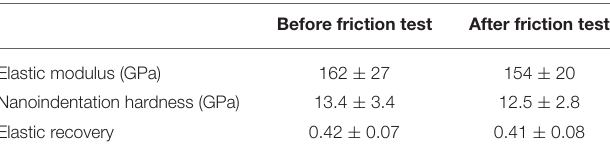
TABLE 3 | The mechanical properties of Tribobond 40 DLC coating surfaces lubricated by L-[CH][Pro]. Before friction test After friction test Elastic modulus